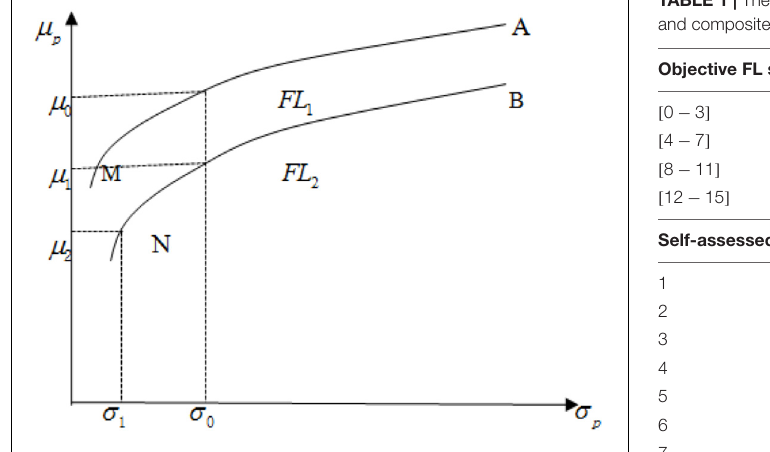
FIGURE 1 | The determinants of portfolio return.